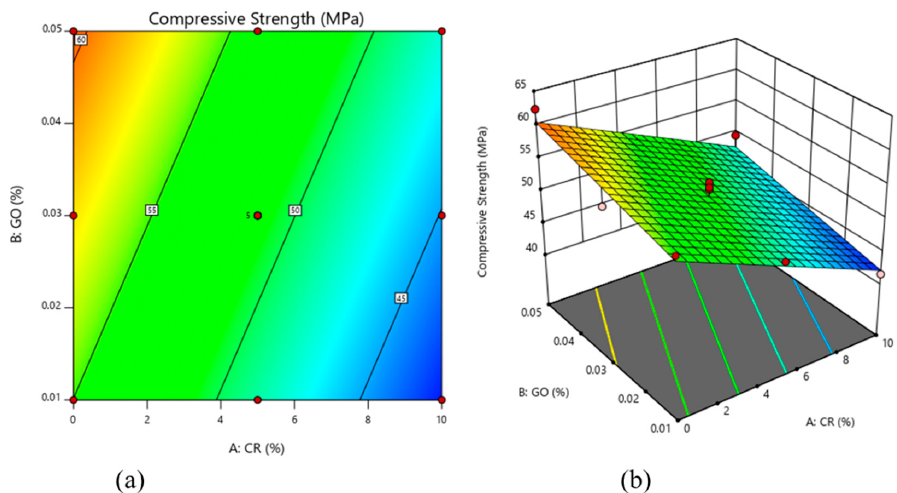
Figure 5. Compressive strength of rubberized ECC with GO: ( a ) 2D contour plot and ( b ) 3D surface